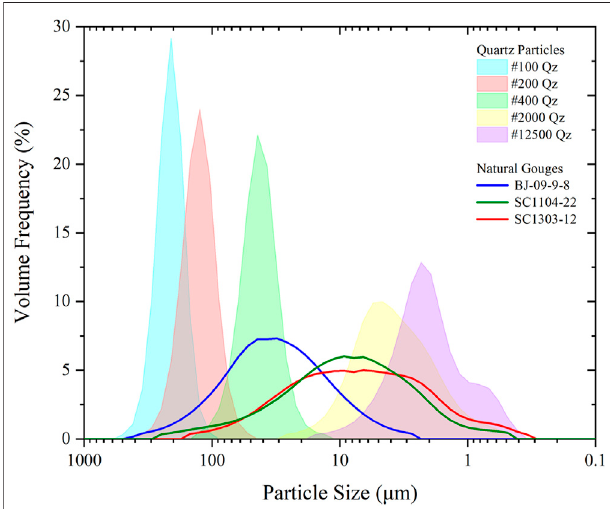
FIGURE 1 | Comparison with the initial particle size distribution (PSD) of the #100 – 12500 meshQz particlesindicatedby colored areas. The solidlines are natural gouges collected from the co-seismic slip zone of the Longmenshan fault zone in Sichuan Province, China P.R. (Chen et al.,